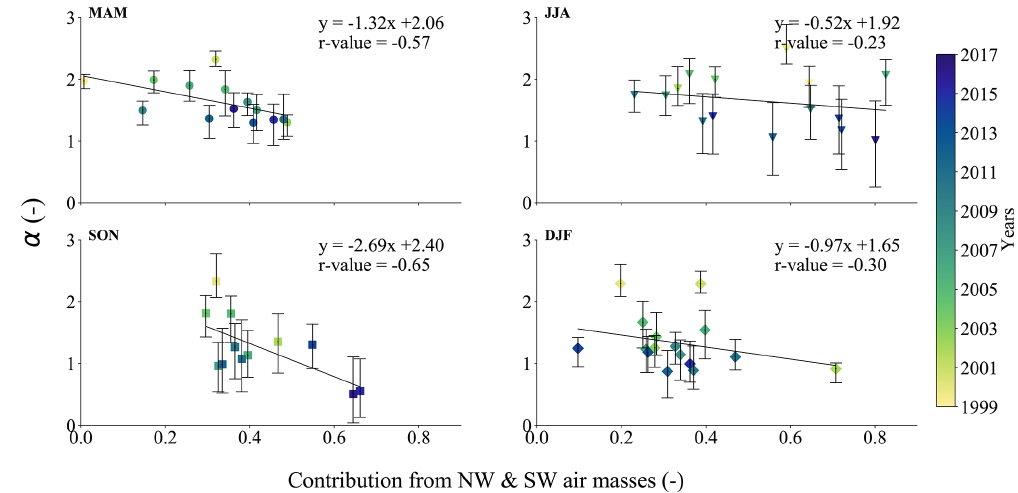
Figure 7. Relationship between the proportion of air masses arriving from the west (i.e. the combination of south-west and north-west regions) with seasonal scattering Ångström exponent ( α ) medians. The four seasons, namely spring (MAM), summer (JJA), autumn (SON), and winter (DJF), are presented. The error bars denote the length of the 25th and 75th percentile values. Note that the number of seasonal medians displayed is larger than the total number of distinct seasons, as winter here is subdivided into the respective years. The ordinary least squares method is applied to the seasonal medians, while the r value denotes the correlation coefficient.